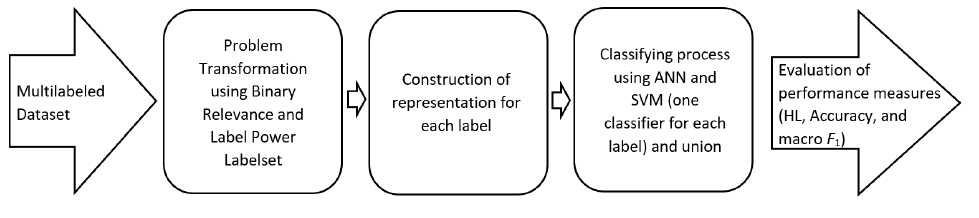
Figure 3. Text processing